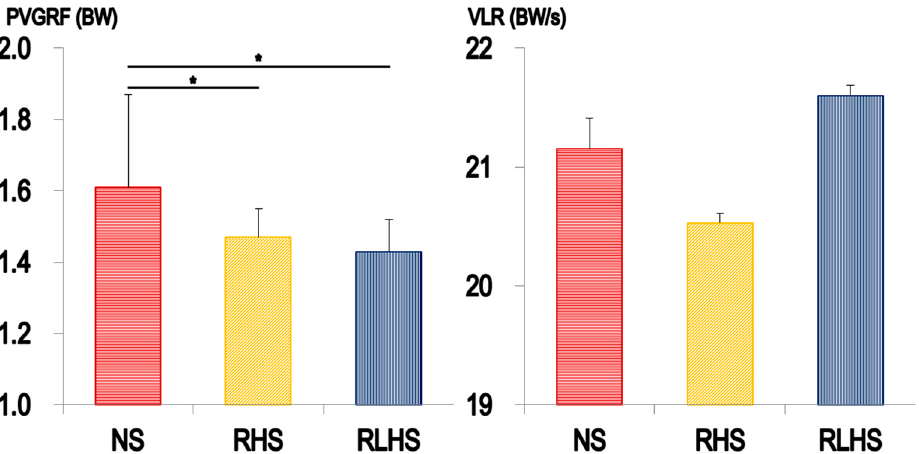
Figure 3. PVGRF (left) and VLR (right) during the stance phase of running. PVGRF: peak vertical ground reaction force, VLR: vertical loading rate, NS: normal shoe, RHS: rounded heel shoe, RLHS rounded lateral heel shoe. * indicates a significant difference between the shoes at α = 0.05.